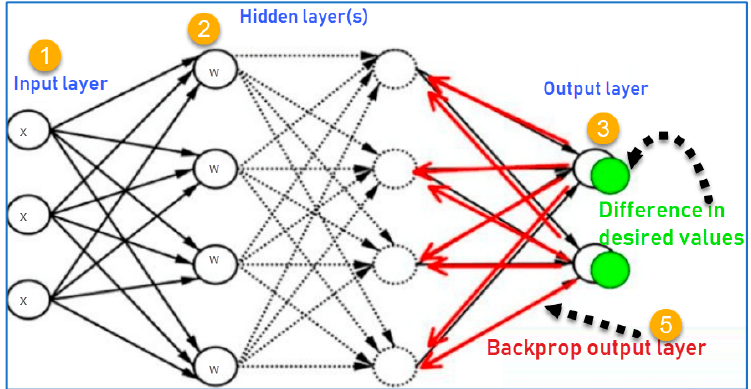
Figure 8. Structural view of the ANN model.